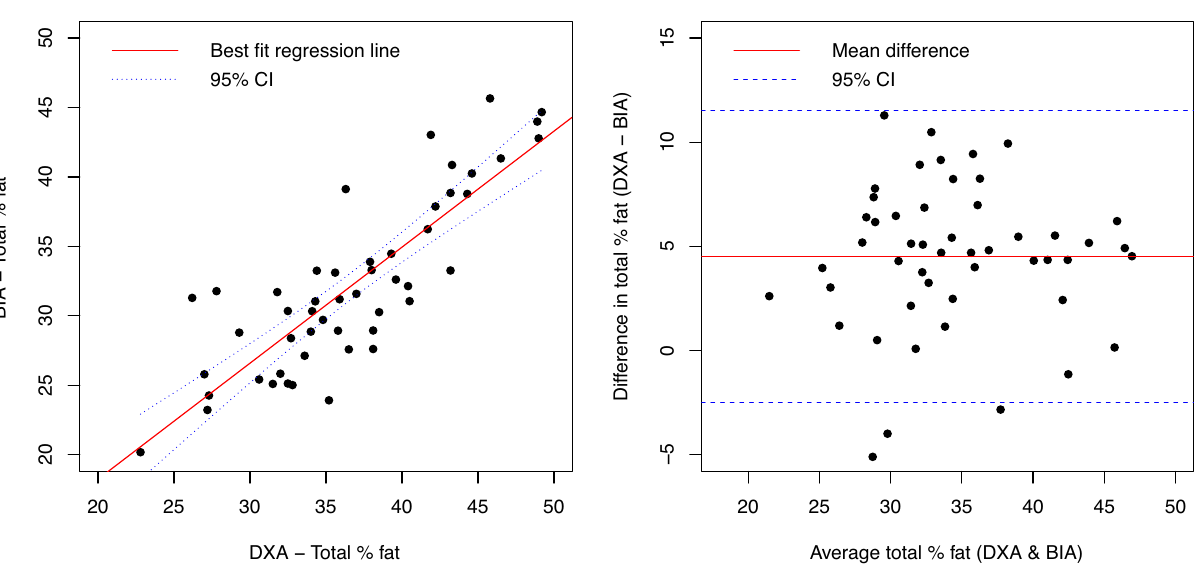
Figure 3. Comparison between bioimpedance (BIA)- and dual X-ray absorptiometry (DXA)-assessed total percent fat. The left panel is a scatter plot of BIA- and DXA-assessed total percent body fat with the best fit regression (solid red line) and 95% confidence intervals (blue dashed); Spearman ρ = 0.80 (p < 0.0001). The Bland Altman plot is shown in the right panel; average difference between BIA-derived and DXA-assessed total percent body fat was 4.5 ± 3.5% (solid red line); 95% confidence intervals are shown as blue dashed